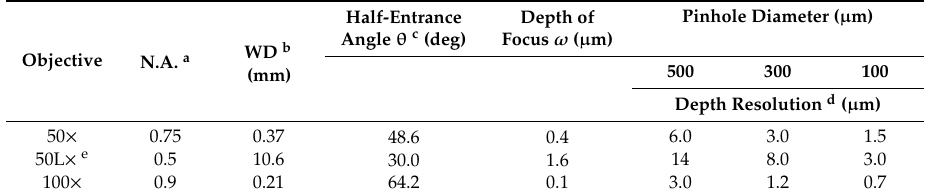
Table 2. The depth resolution of a confocal Raman microscope as a function of objective lens and pinhole diameter [12].